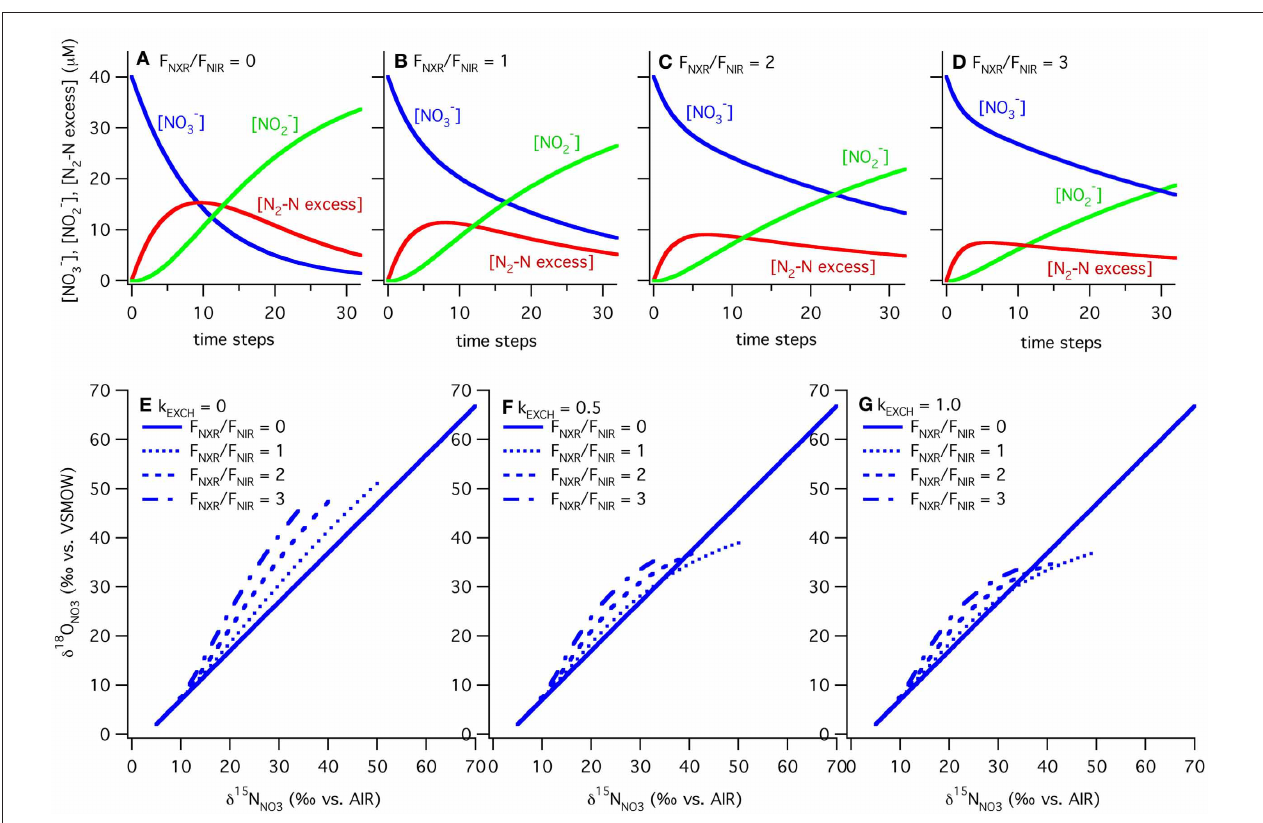
FIGURE 6 | Results of ODZ model for varying ratios of nitrite oxidation to nitrite reduction and rates of exchange. Results from the ODZ box model at different relative rates of nitrite oxidation and nitrite reduction (F NXR /F NIR ), ranging from 0 to 3. Mass balance is maintained in the model between NO − 3 , NO − 2 and excess N 2 -N with F NXR /F NIR = 0 (panel A ), 1 (panel B ), 2 (panel C ) and 3 (panel D ). NO − 2 accumulation and N 2 production decrease as F NXR increases. The ODZ box model shows that NO − 2 cycling can generate both positive and negative (cid:2)( 15 , 18 ) values, depending on the extent of NO − 3 consumption (increasing δ 15 N, δ 18 O values), the relative